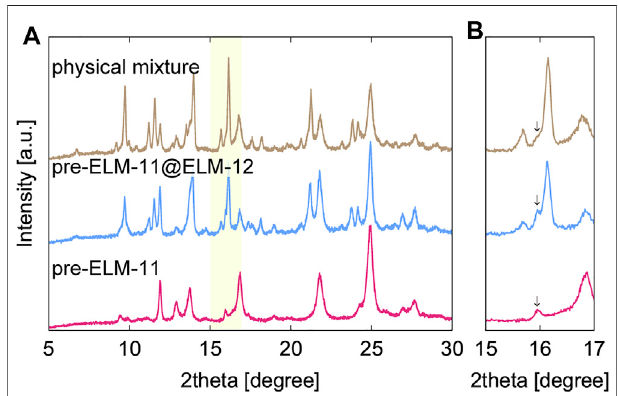
FIGURE 10 | (A) XRD patterns of ELM-11@ELM-12 and a physical mixture of ELM-11 and ELM-12 after the air exposure. As a reference, XRD pattern of ELM-11 after the air exposure is also shown, which is same as that in Figure1B -c. (B) Amagni fi edgraphcorrespondingtotheshadedarea in